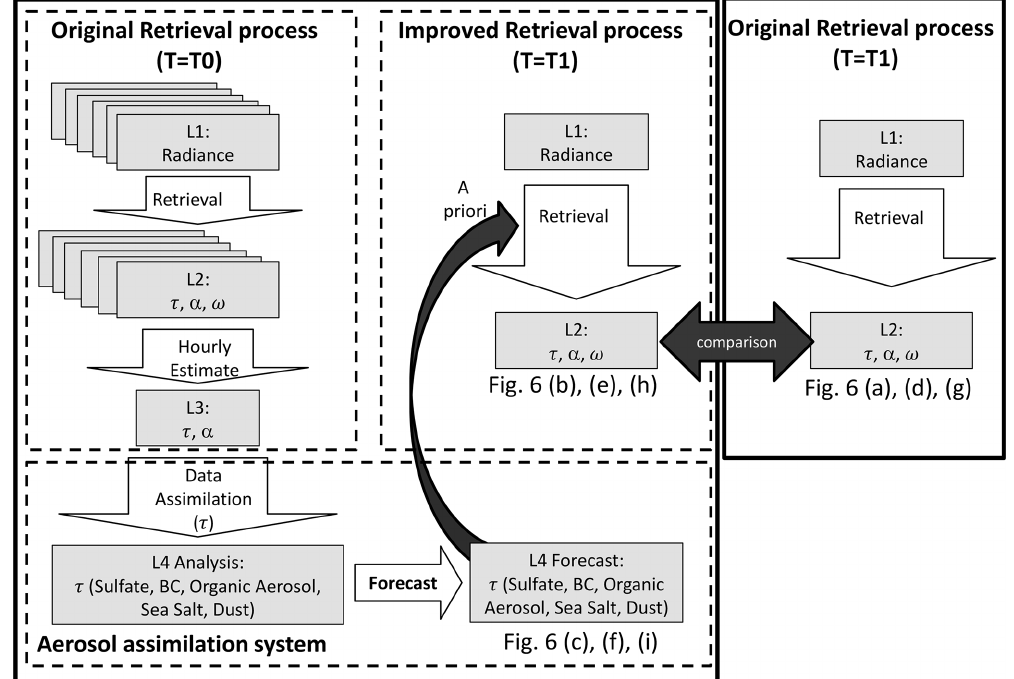
Figure 1. Flowchart of data processing for aerosol retrieval at time T 1 .